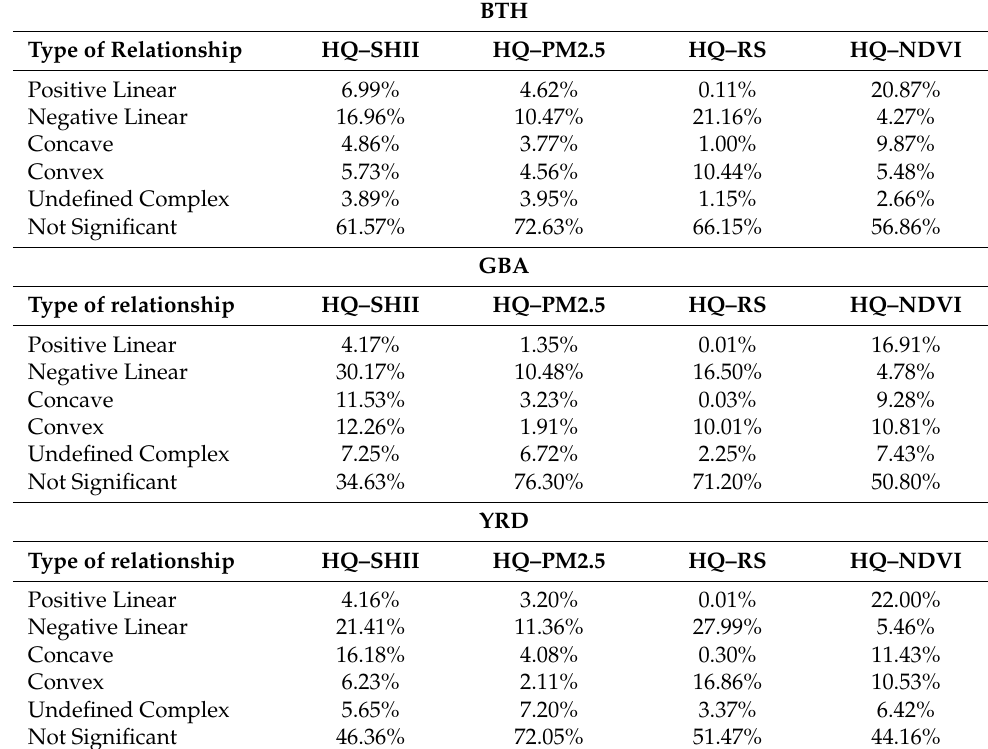
Table 2. Categorical summary of the local bivariate